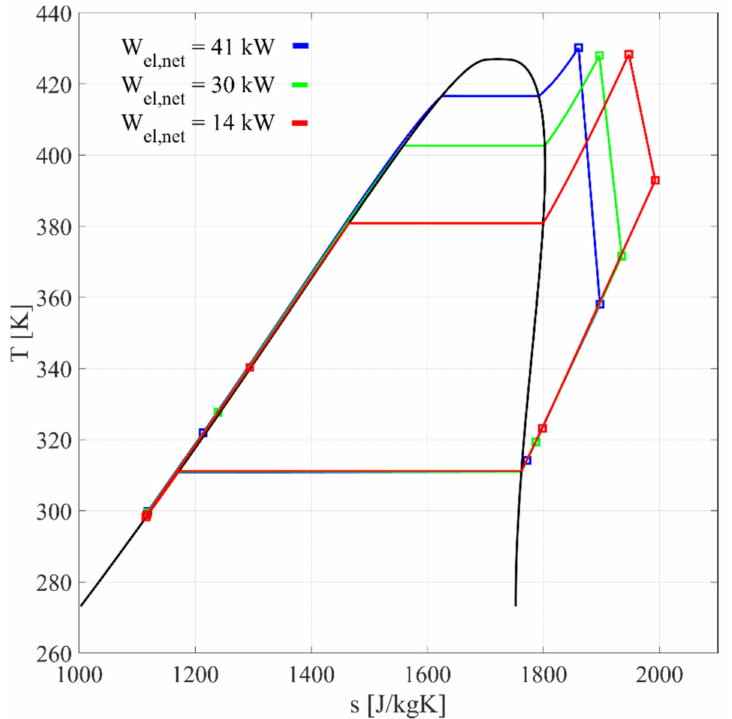
Figure 6. Off-design ORC cycles for different part-load conditions.